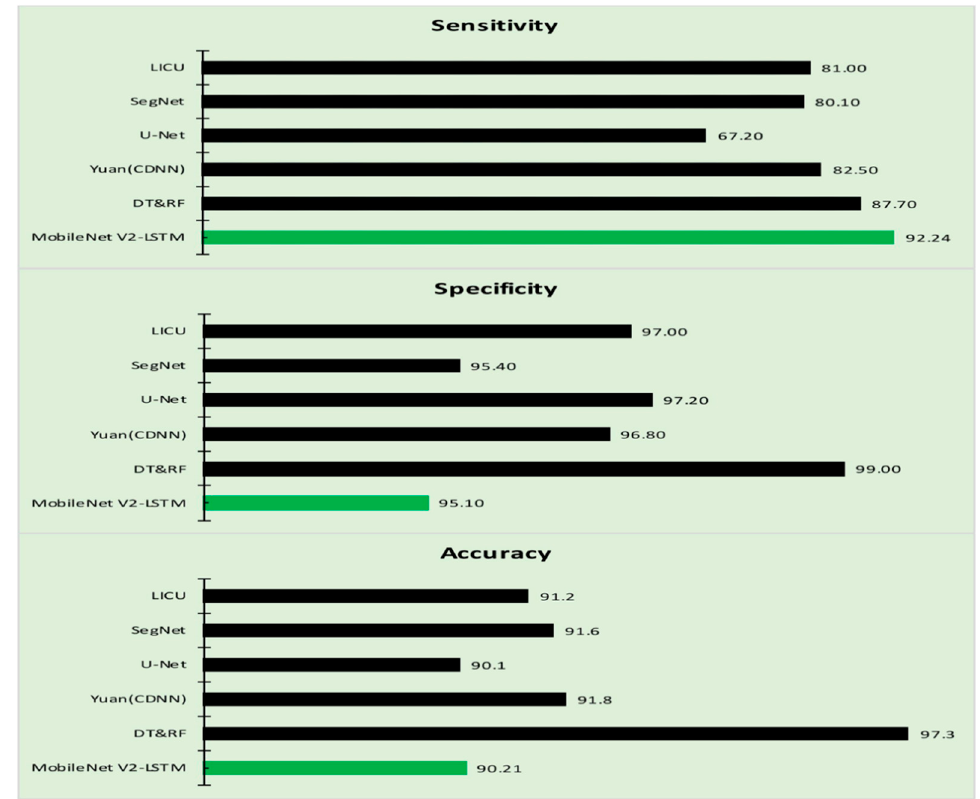
Figure 10. The comparative analysis of MobileNet V2-LSTM model.